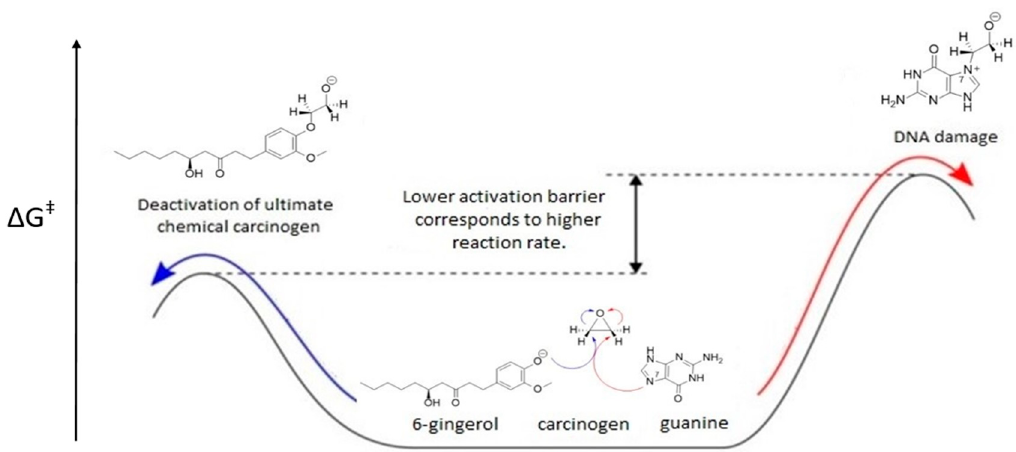
Figure 2. Activation free energy ∆ G ‡ for the reaction between the chemical carcinogen and natural scavenger (blue arrow) in comparison with activation free energy for competing reaction between the chemical carcinogen and guanine (red arrow).